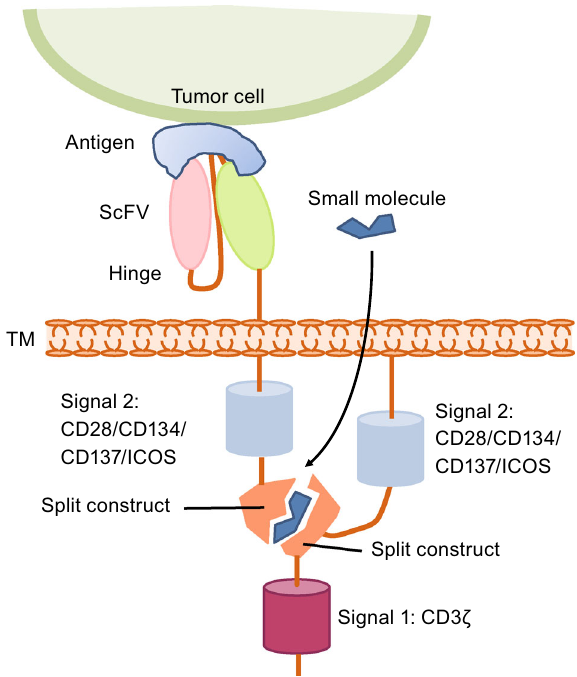
Figure 5. CAR T cells with “ ON switch ”— small molecules. Only when the small molecule is present can two parts of CAR be reassembled with the split construction to activate CAR T cells. The design strategy of an AND logic gate that requires “ antigen + small molecule ” together for T cell activation. ScFv, single chain variable fragment; ICOS, inducible T cell costimu- lator;